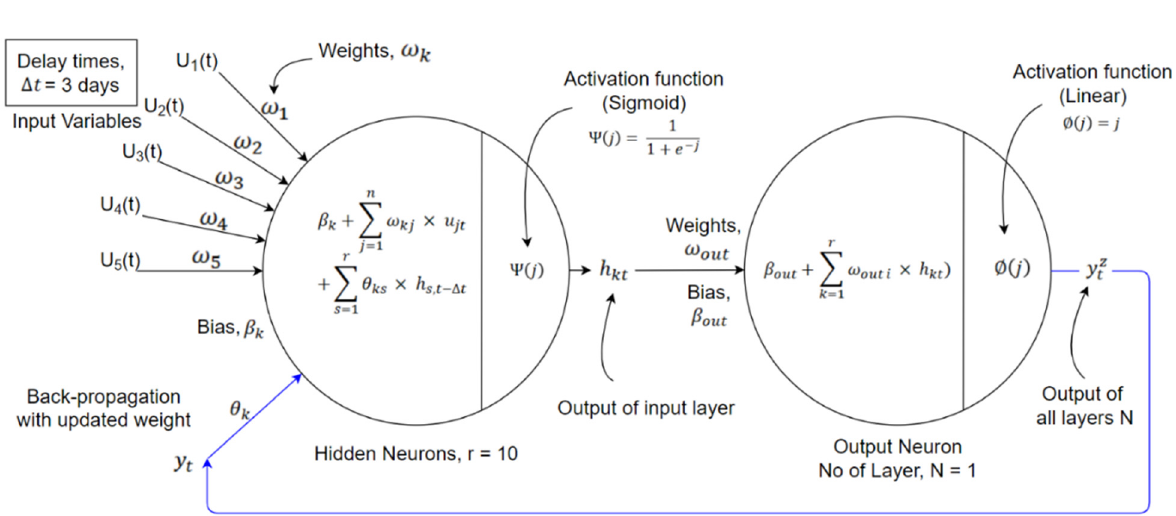
Figure 2. NARX Network’s design used in this article (can be replicated) with 5 input variables, 1 output variable, 10 hidden neurons and a delay time of three days.